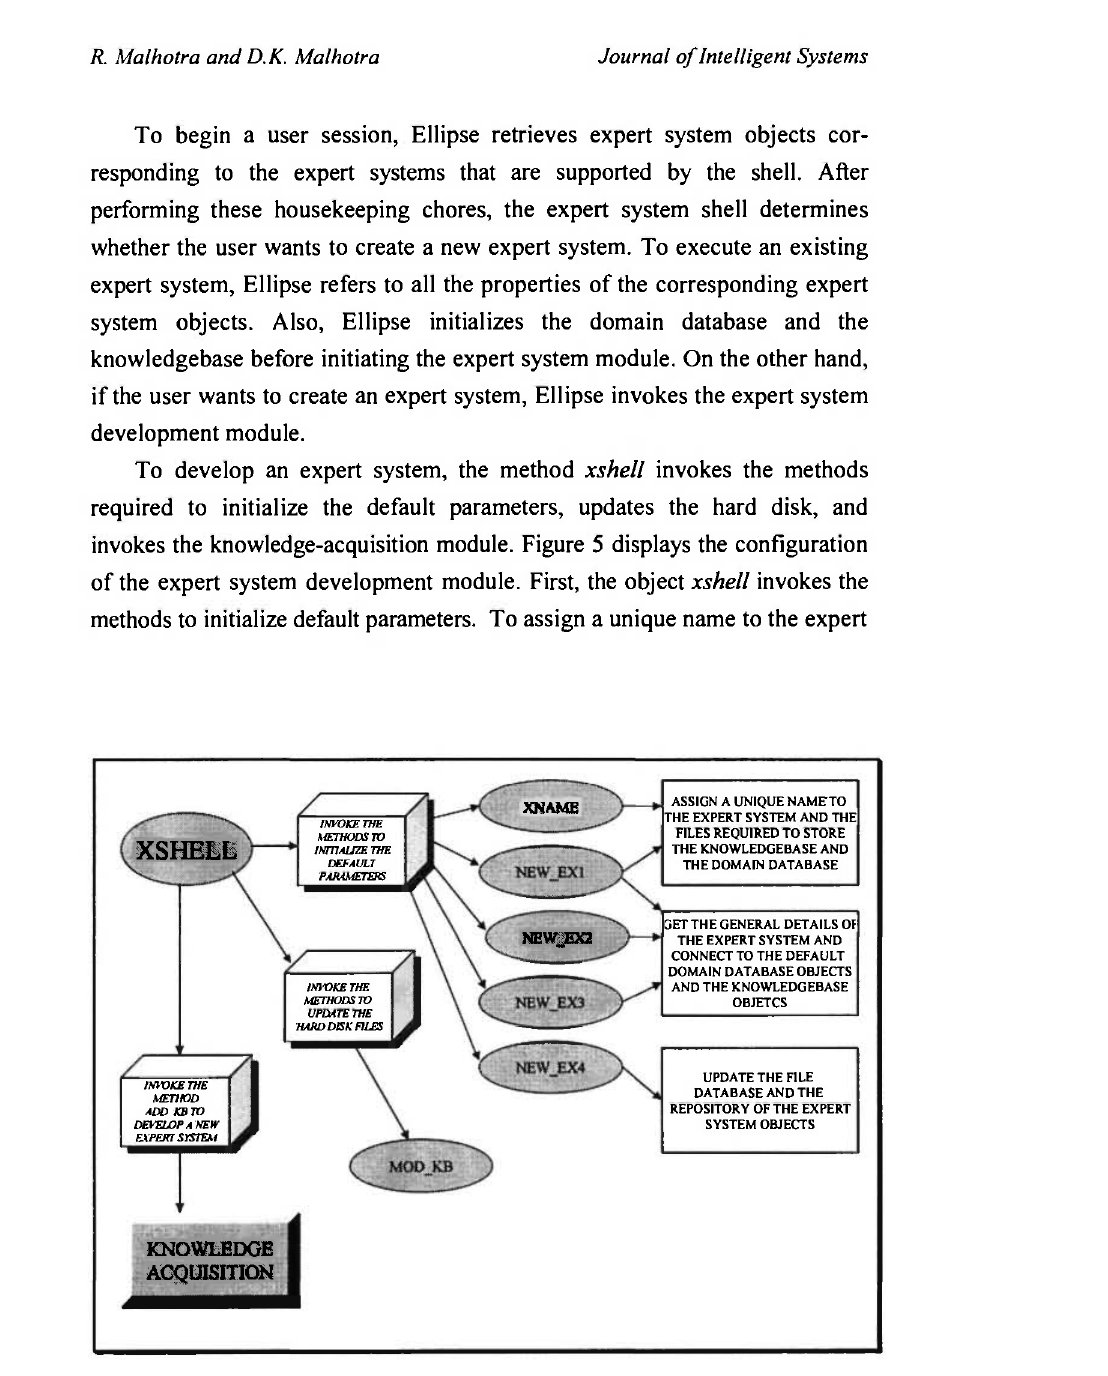
Fig. 5: Expert system development